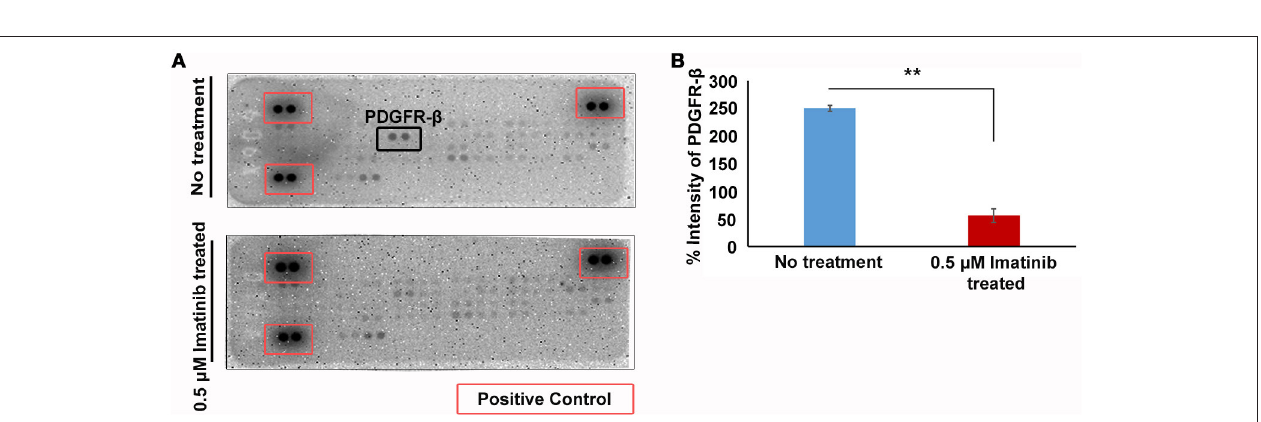
FIGURE 6 | Phospho-tyrosine profiling of somatotropinomas treated and untreated with 0.5 µ M Imatinib. ** P < 0.01. (A) Phospho-tyrosine profiling of somatotropinomas treated and untreated with 0.5 µ M Imatinib. Note the absence of PDGFR- β after imatinib treatment (B) Bar diagram showing reduction in PDGFR- β levels after treatment with 0.5 µ M imatinib in primary culture of somatotropinoma cells ( P <